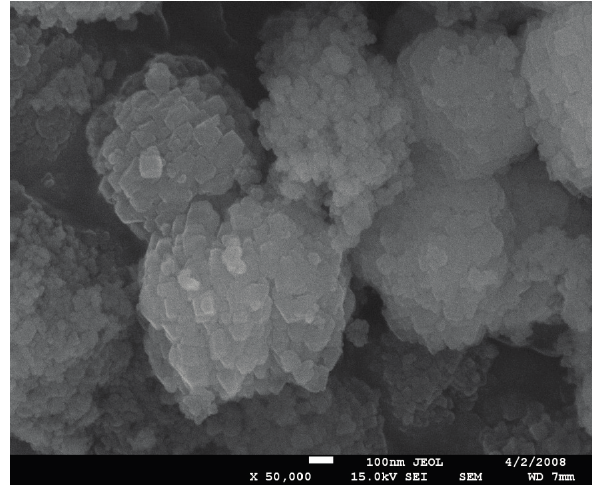
Figure 2. SEM microphotograph of ZSM-12 type